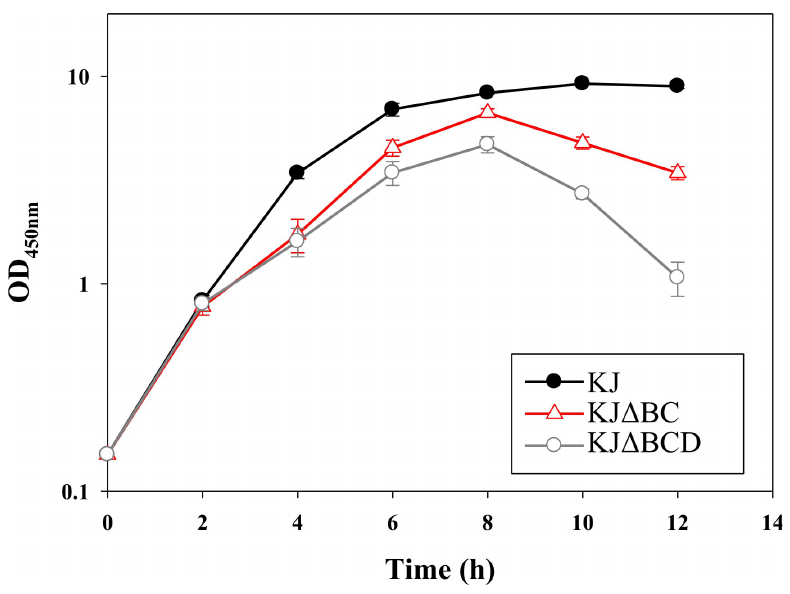
Fig 6. The roles of creBC and creD in membrane susceptibility to Triton X-100. The overnight-cultured bacteriawere inoculated into fresh LB broth containing Triton X-100 of 200 μ g/ml at the initial OD 450 of 0.15. The bacterialgrowth was monitored by recording the OD 450nm . Data are the means from three independent experiments. Error bars indicatethe standarddeviationsfor three triplicate samples.